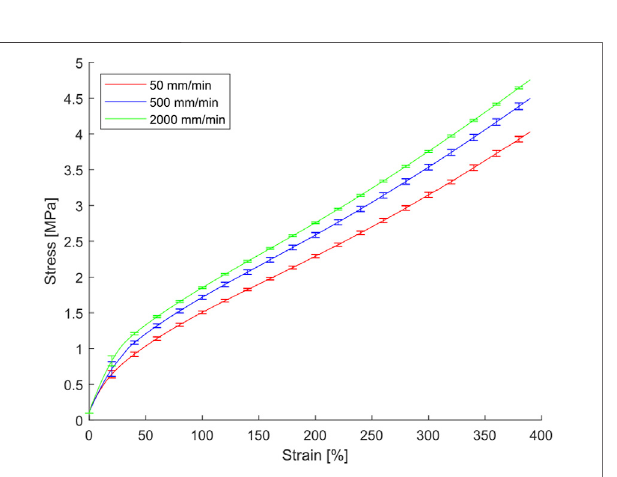
FIGURE 8 | Rate-dependent stress F02D strain curves of the MS2-3 silicone membrane.